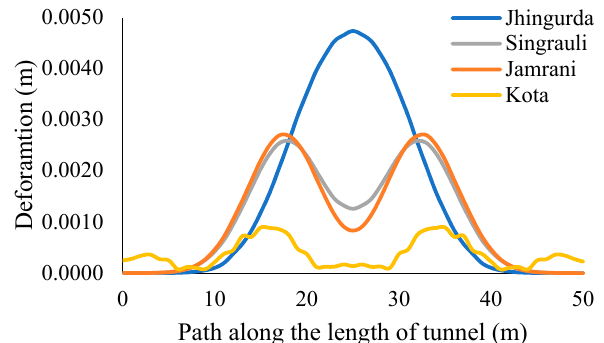
Figure 6. Comparison of deformation profile generated under the response of impact load .